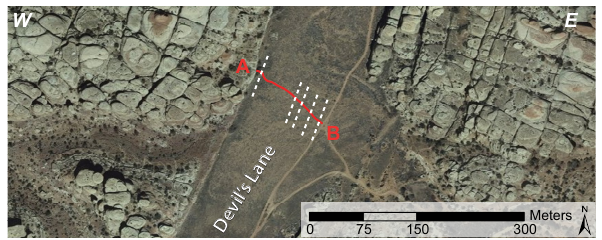
Figure 8. Aerial photograph of the WNW–ESE (red line) profiles crossing through Devil’s Lane. (a) Interpreted faults are indicated by white dashed lines.